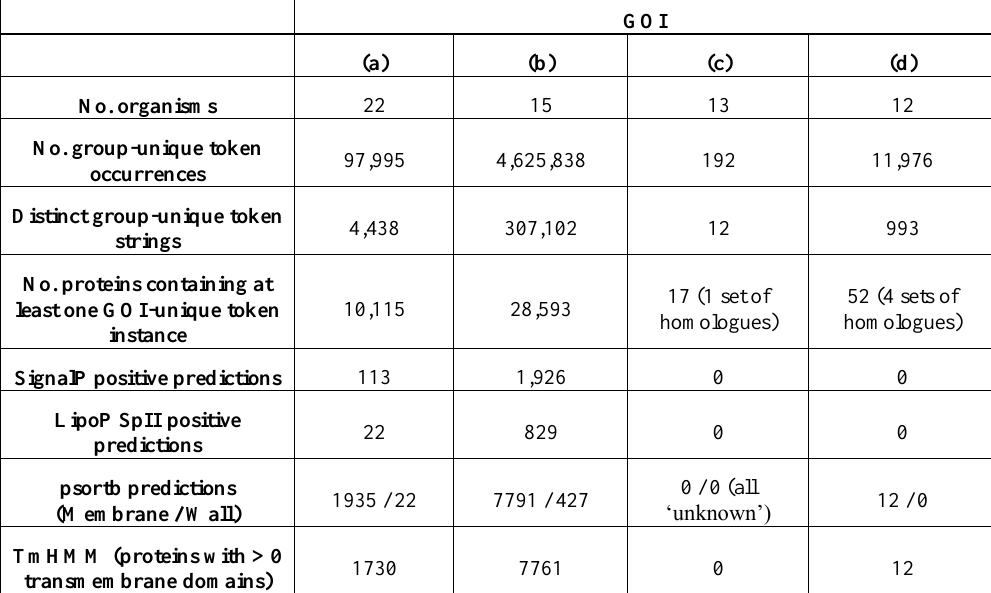
Table 2: A number of groups of interest (GOIs) were defined (a-d), which were analysed by the analysis pipeline. The number of distinct tokens for each group is shown, together with a summary from various SCL prediction tools for the set of proteins for which at least one distinct token string was present. The GOIs were: a) a group containing all organisms listed in Table 1; b) a subgroup containing just the S. aureus strains; c) a subgroup containing organisms for which any evidence of methicillin resistance existed; d) an alternative methicillin